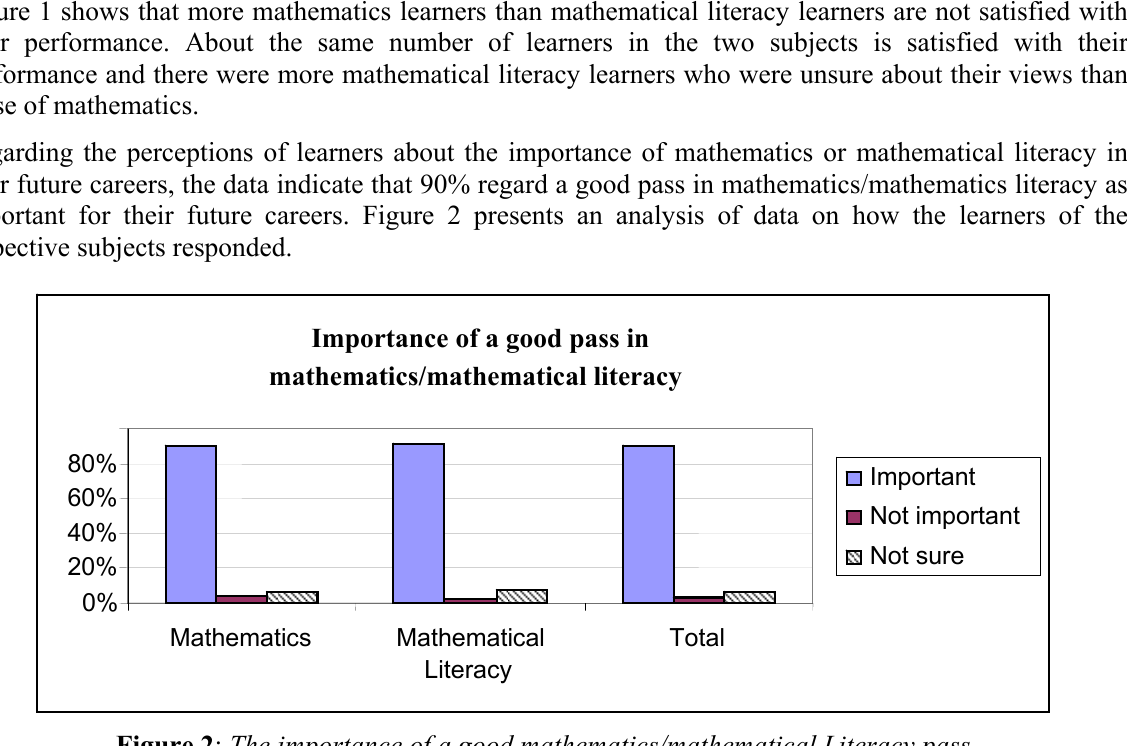
Figure 2 : The importance of a good mathematics/mathematical Literacy